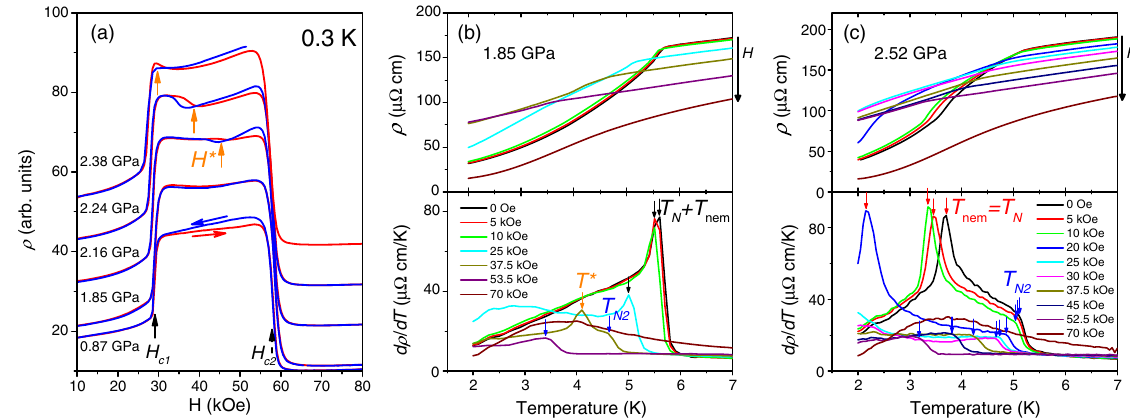
FIG. 4. (a) In-plane electrical resistivity of CeAuSb 2 as a function of magnetic field applied along the c axis at 0.3 K for representative pressures. Magnetoresistance from increasing- and decreasing-field ramps is plotted by red and blue lines, respectively. Data at different pressures are shifted for clarity. (b,c) Low-temperature in-plane electrical resistivity for various applied magnetic fields at 1.85 GPa and 2.52 GPa. Here, ρ and d ρ = d T as a function of temperature are shown in the upper and bottom panels, respectively. ab region (M) reveals n ≈ 1 at ambient pressure. The similar color map for the exponent n in Ref. [18] does not display